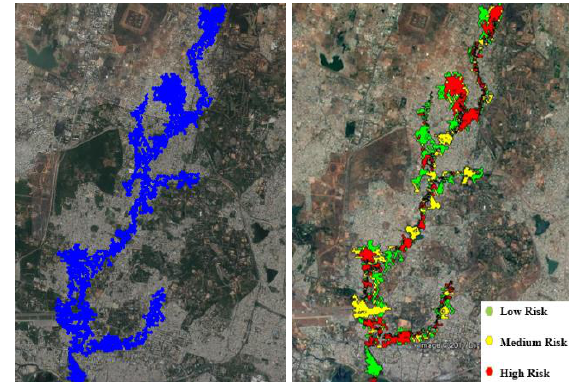
Figure 10: Zone XIII flood inundation map (left) and flood risk map (right)